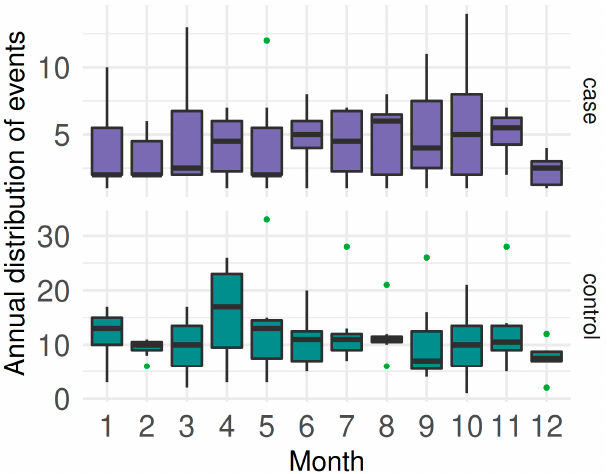
Figure 3. Boxplots of monthly distribution of CSF cases and controls from 2014 to 2020 in Ecuador (different scales on the y-axis).